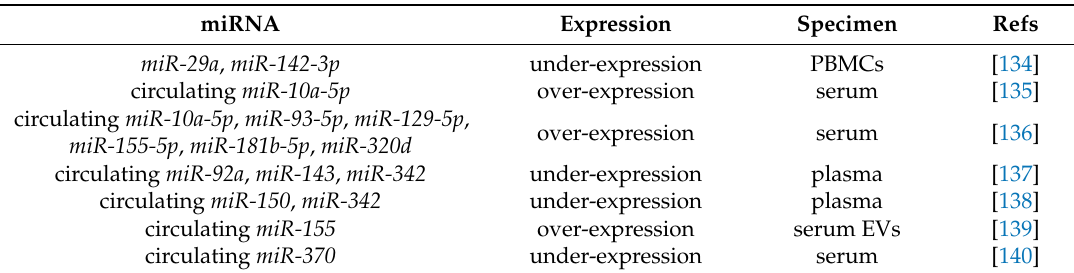
Table 3. miRNAs as diagnostic biomarkers in AML.